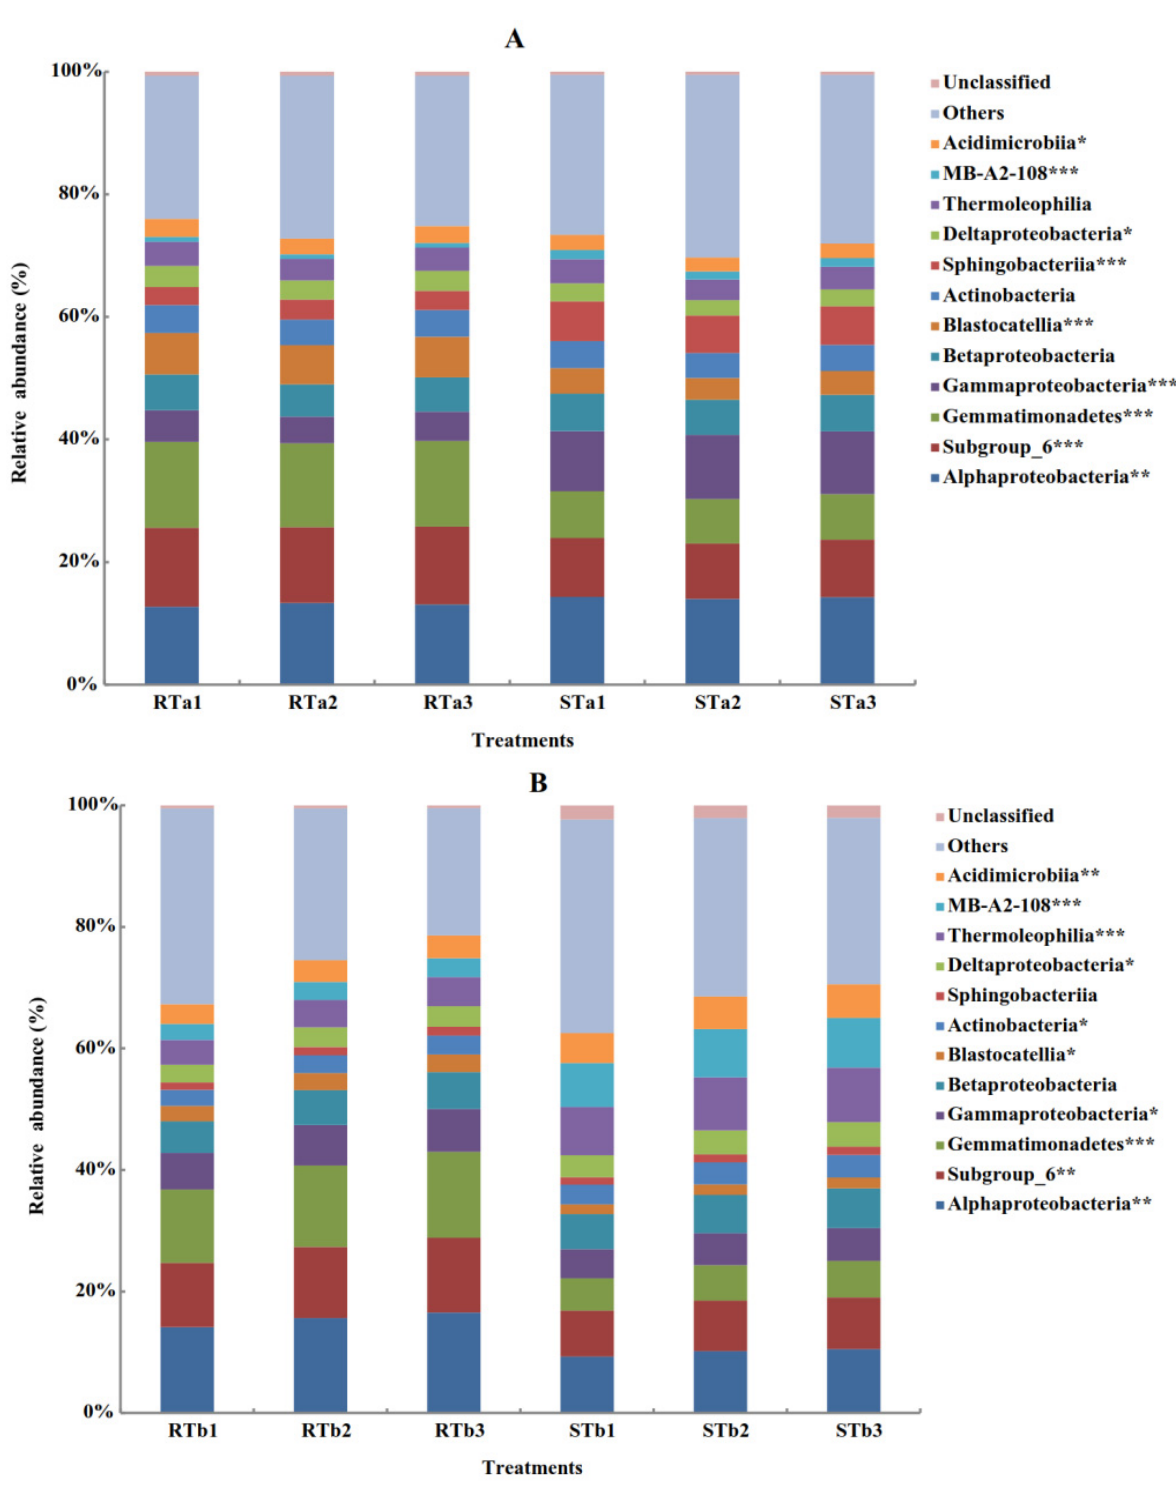
Figure 5. Comparison of the dominant bacterial communities at class level (%) in different samples.